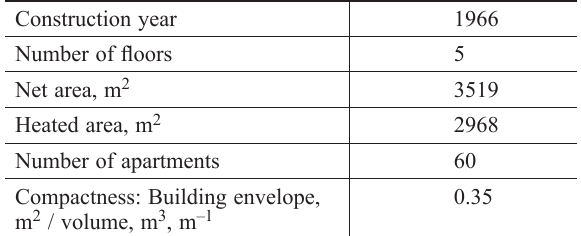
Table 1. Characteristics of the renovated